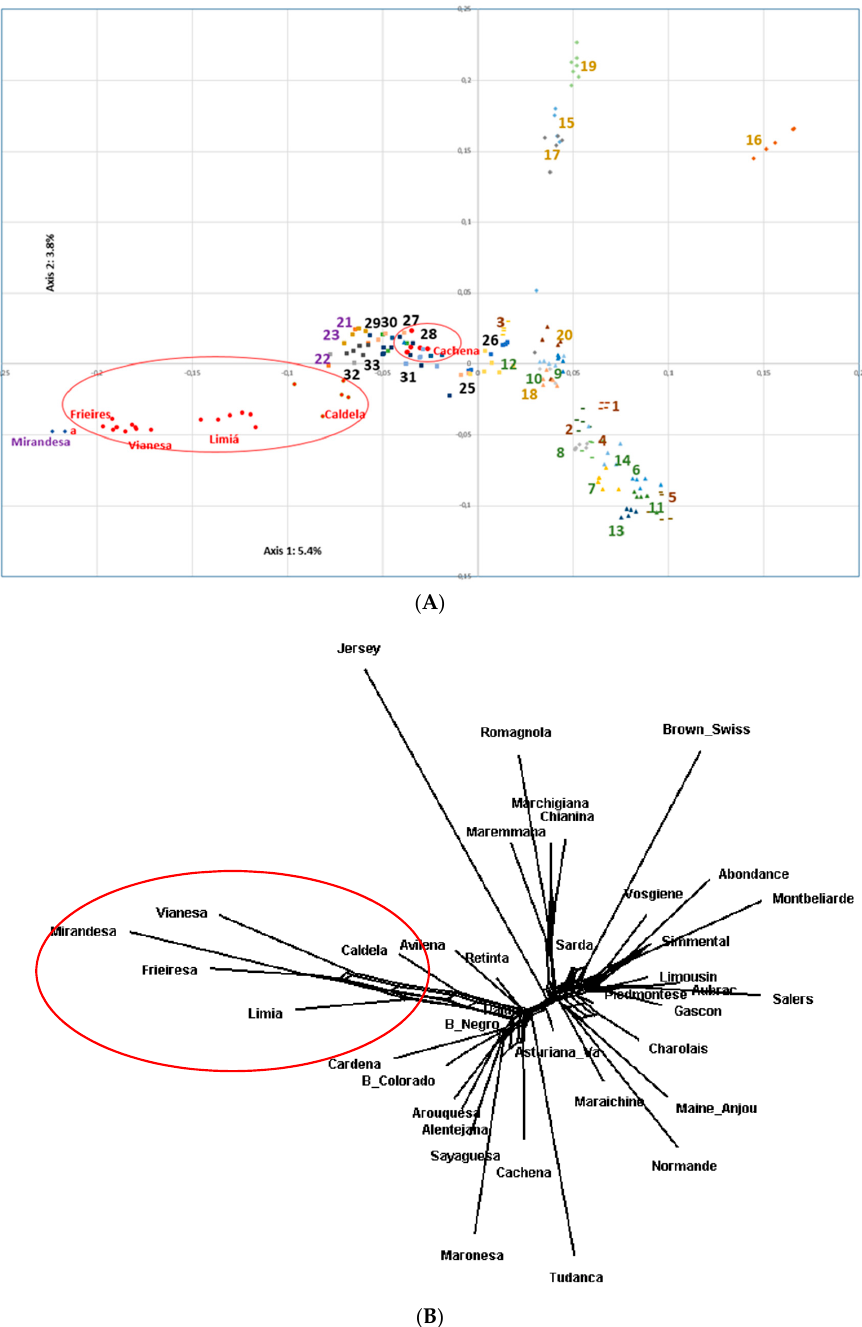
Figure 5. ( A ) PCA analysis among 38 European and Morenas Gallegas bovine breeds. Squares, triangles, and diamonds represent Iberian Peninsula (25: Asturiana de los Valles, 26: Avileña, 27: Berrenda